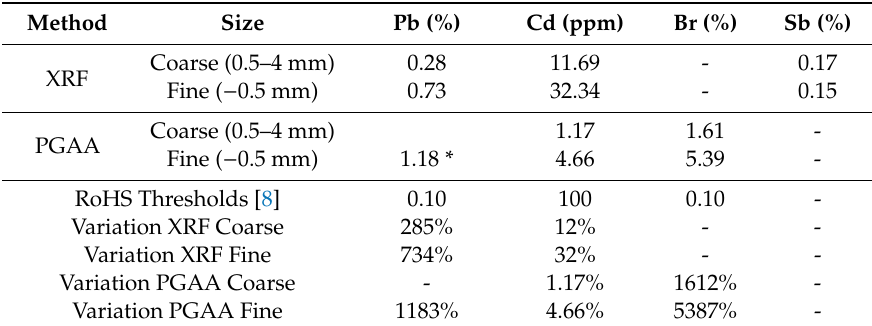
Table 2. Chemical composition of hazardous elements within the PCBs. The size fractions were divided into coarse and fine fractions, similar to the procedure from Figure